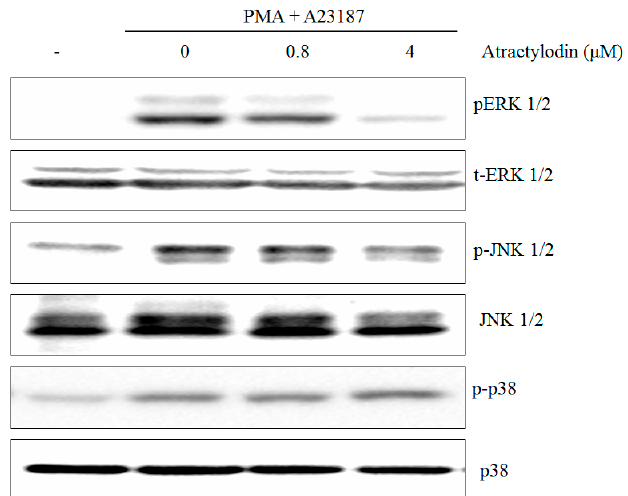
Figure 3. Effects of atractylodin on the phosphorylation of MAPKs in stimulated HMC-1. HMC-1 was treated with the indicated concentrations of atractylodin for 0.5 h prior to being incubated with PMA (50 nM) plus A23187 (1 µ M) for 0.5 h. Whole cell lysates were then analyzed by Western blot. Equal amounts of protein (20 µ g) were then separated by SDS-polyacrylamide gel electrophoresis and immunoblotted with antibodies.